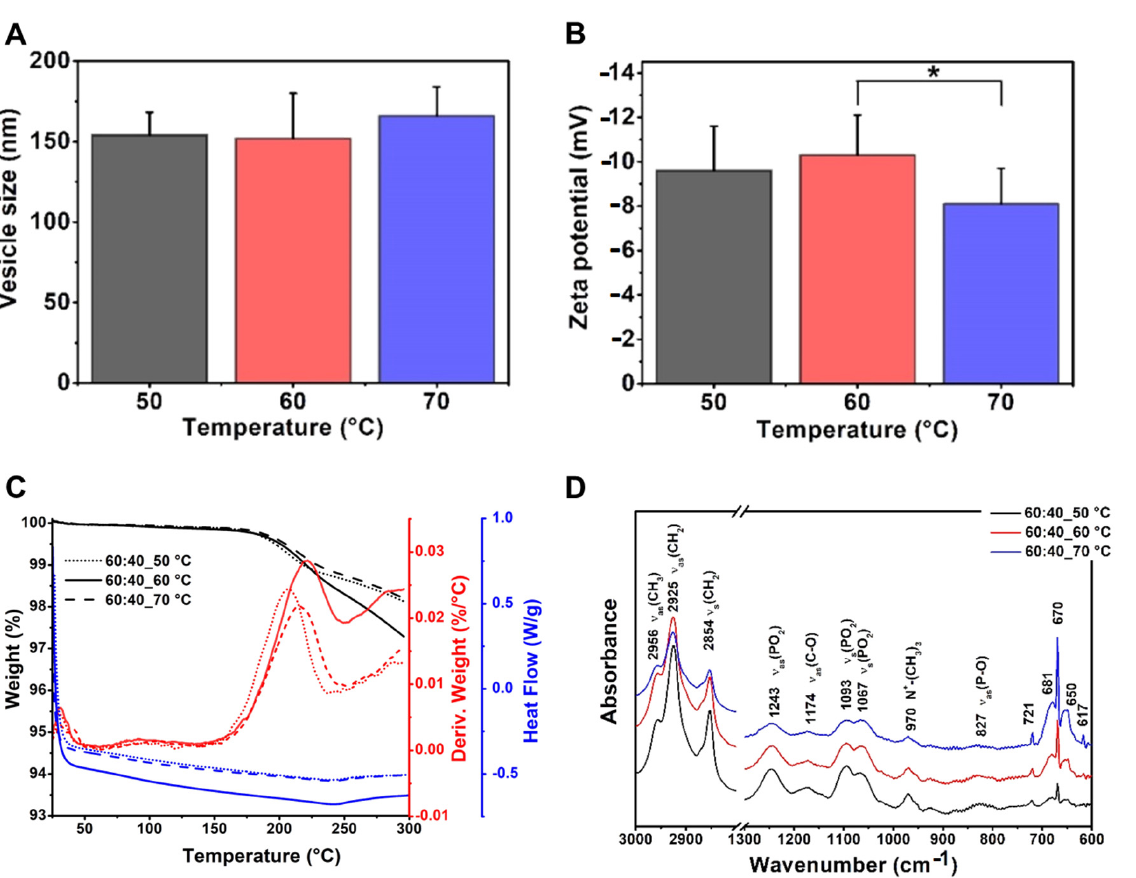
Figure 4. Characteristic features of the liposome samples prepared at different temperature values (50, 60 and 70 °C) from PC-CH 60:40 mass ratio composition, and hydrated with saline solution, presenting the results of the investigations: vesicle size and zeta potential analysis ( A , B ), differential scanning calorimetry and thermogravimetric analysis ( C ) and Fourier-transform infrared spectroscopy ( D ). *: p < 0.05